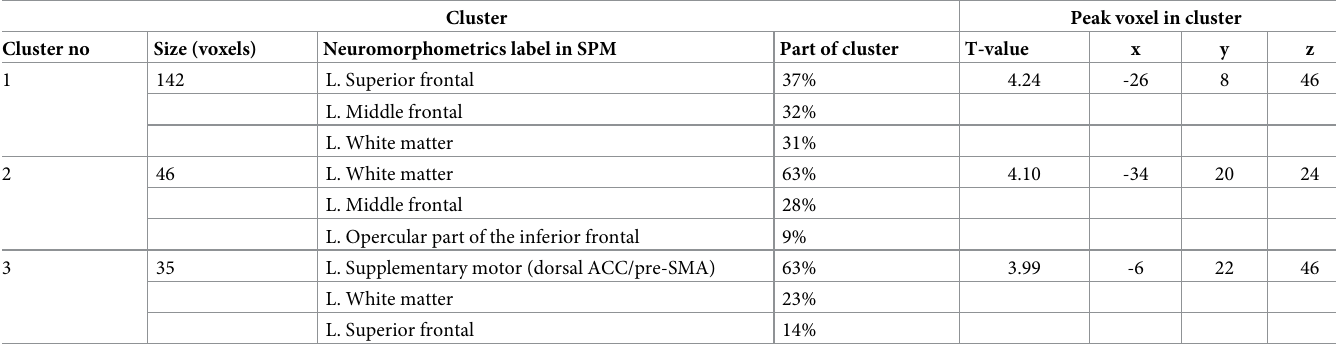
Table 4. Detailed description of the cluster information.